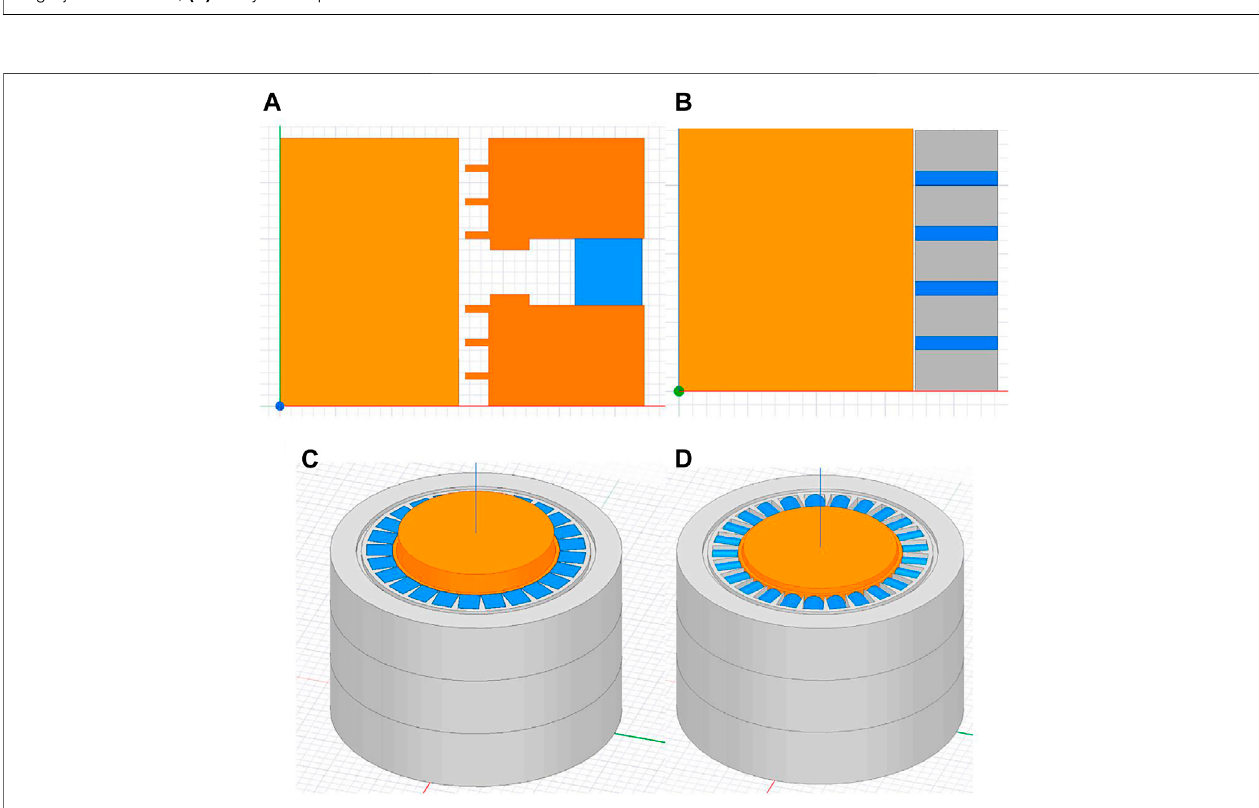
FIGURE 6 | Figure of the seal model. (A) Classic FF seal; (B) FF radial-charged seal; (C) FF cuboid magnet seal; (D) FF cylindrical magnet seal.